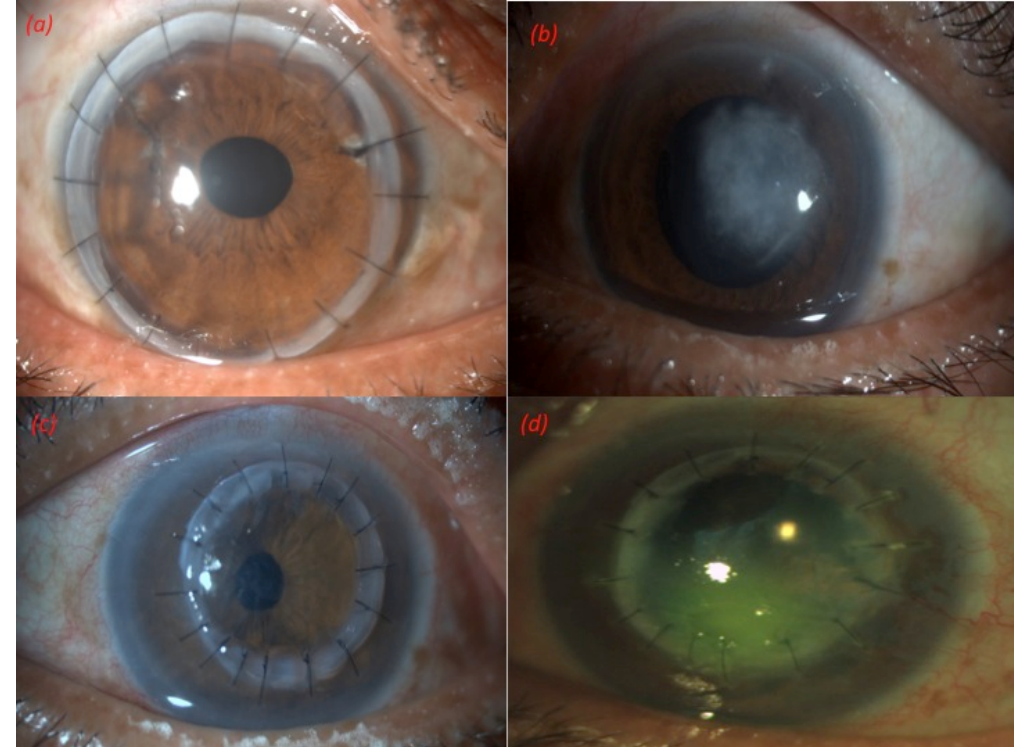
Figure 1: (a) Right eye showing a compact graft, with intact sutures and well-formed anterior chamber. (b) Left eye showing epithelial defect with whitish grey midstromal infiltrate in the mid periphery measuring 5 mm x 5 mm with ill-defined margins. (c) One week post therapeutic penetrating keratoplasty. (d) Six months postoperatively, midstromal infiltrate measuring 4 mm x 4 mm with an overlying epithelial